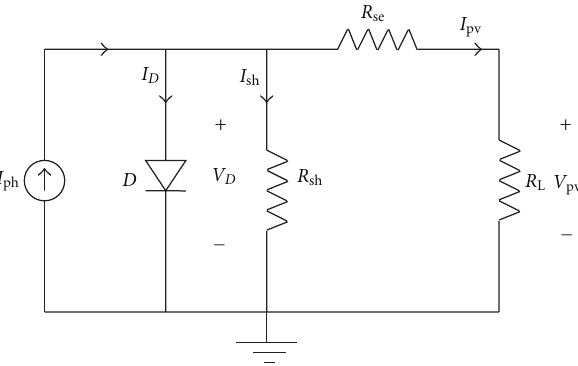
Figure 2: Electrical equivalent circuit model of a SPVA in I